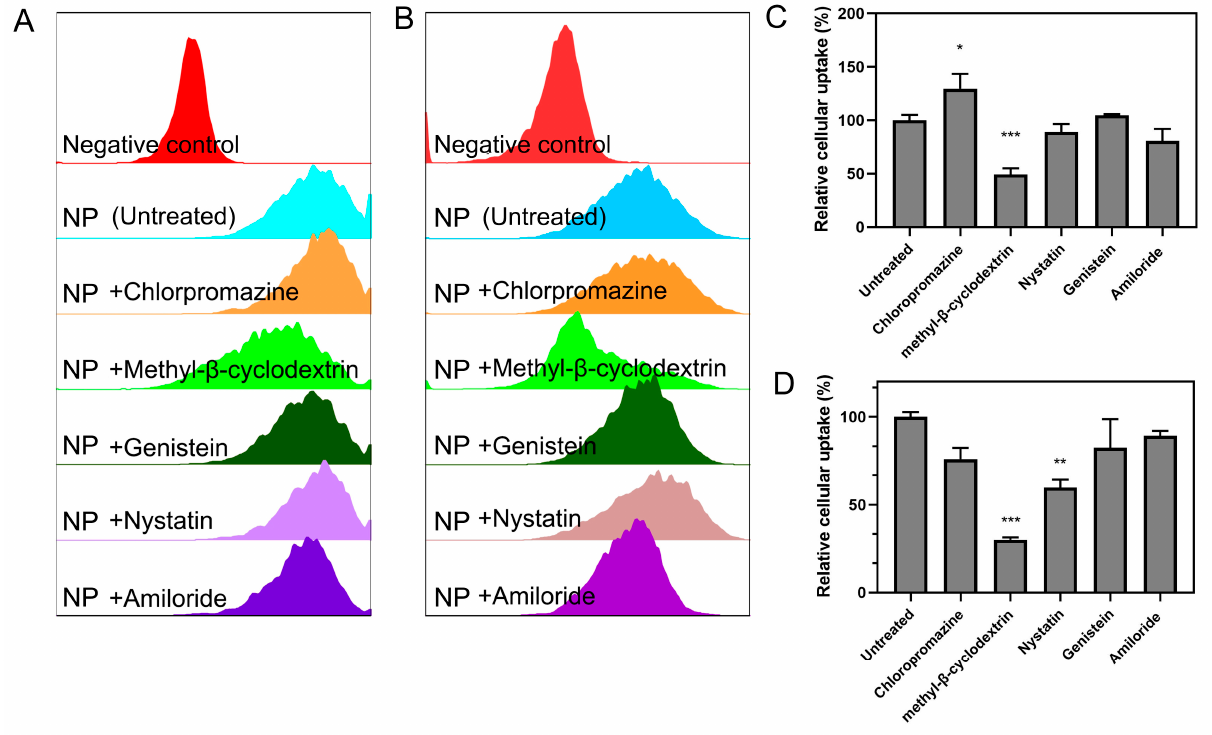
Figure 5. Endocytosis pathway analysis of CEL/Cy5-siRNA nanocomplexes. Endocytosis pathway analysis of CEL/Cy5-siRNA nanocomplexes in ( A ) H1299–Luc cells and ( B ) HeLa–Luc cells by flow cytometry in the presence of endocytosis-specific inhibitors. Either nanocomplexes nor endocytosis-